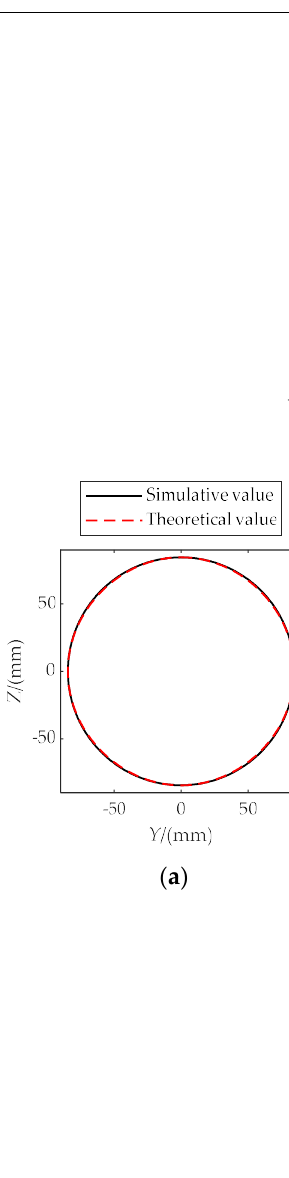
( b ) Figure 9. ( a ) Target point; ( b ) circular trajectory.